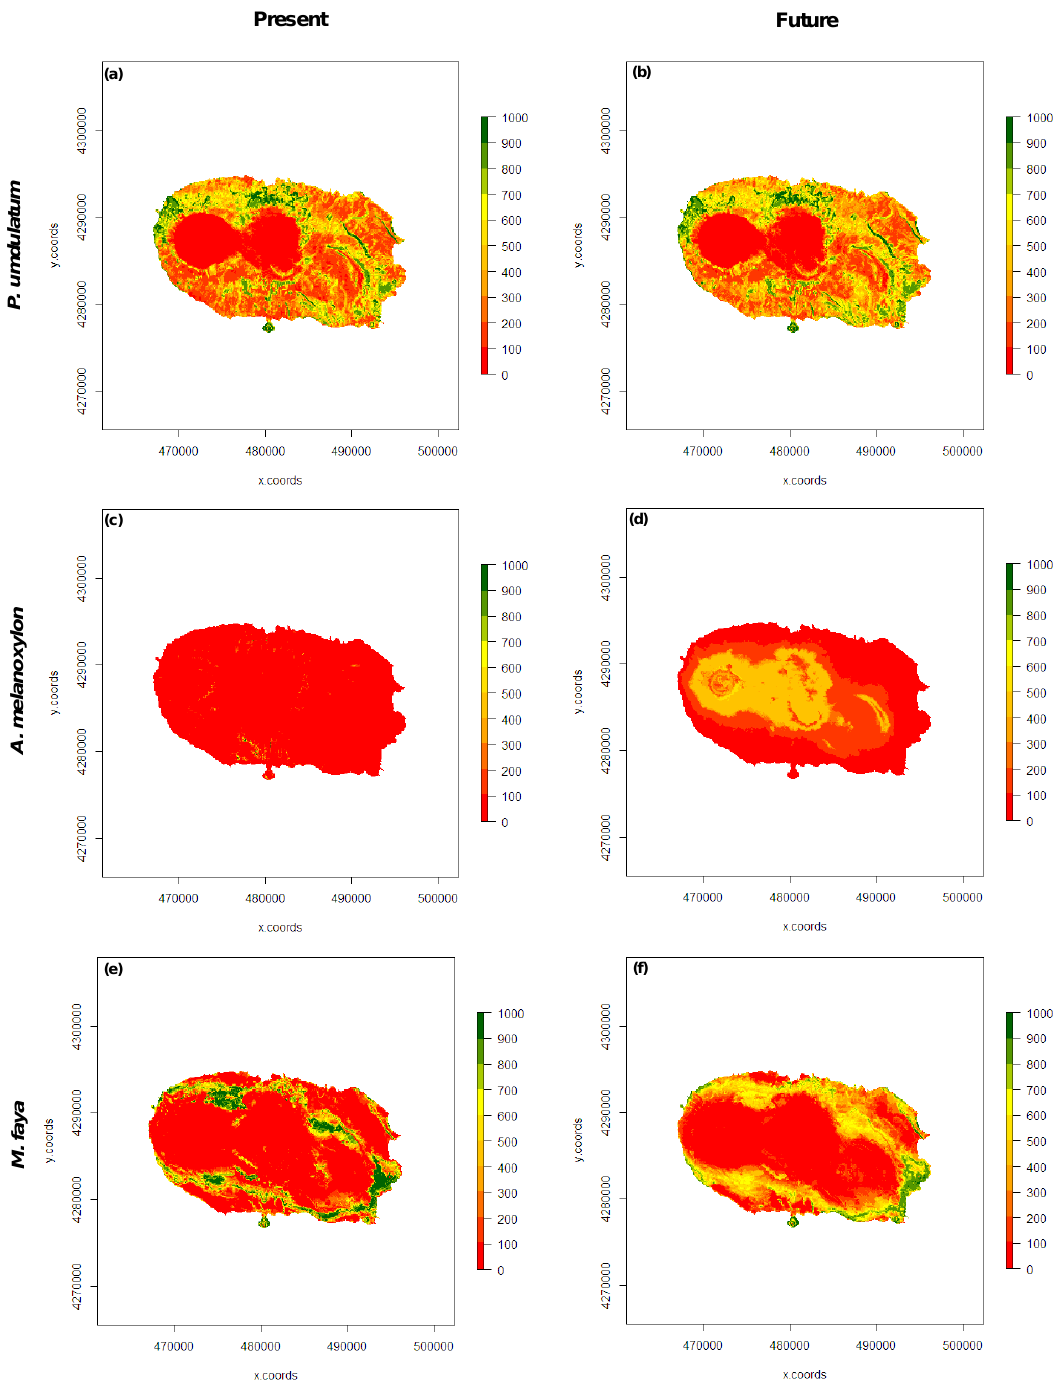
Figure 8. Present and future species distribution maps modelled for Terceira Island: ( a , b ) P. undulatum , ( c , d ) A. melanoxylon, and ( e , f ) M. faya . Evaluation measure, AUC: Area under the receiver operating characteristic curve. EGV set 2. A probability scale from 0 to 1000 was used to facilitate map reading.